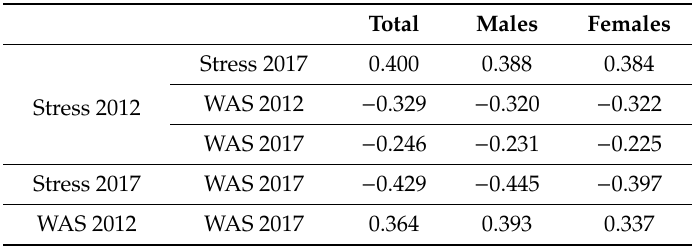
Table A1. Spearman correlations between X and Y variables in the mediation analysis for the years 2012 and 2017 for the total group and separate for males and females ( N = 1432, n = 575, n = 857). Total Males Females Stress 2017 0.400 0.388 0.384 WAS 2012 − 0.329 − 0.320 − 0.322 Stress 2012 WAS 2017 − 0.246 − 0.231 − 0.225 Stress 2017 WAS 2017 − 0.429 − 0.445 − 0.397 WAS 2012 WAS 2017 0.364 0.393